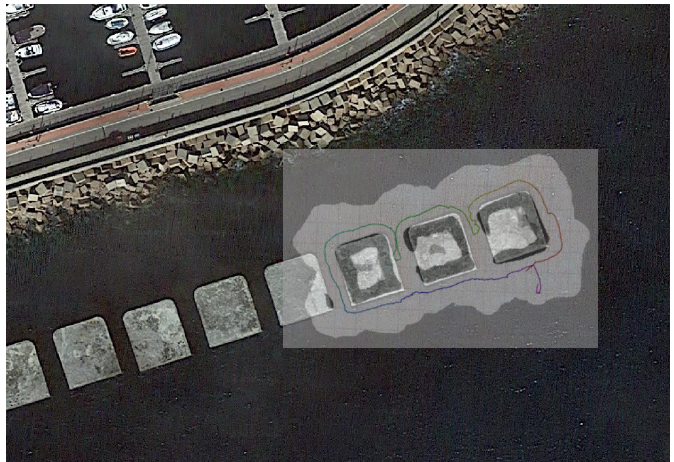
Figure 17. Breakwater HM superimposed with a satellite image (source: Map data c (cid:13) 2018 Google, Inst. Geogr. Nacional,